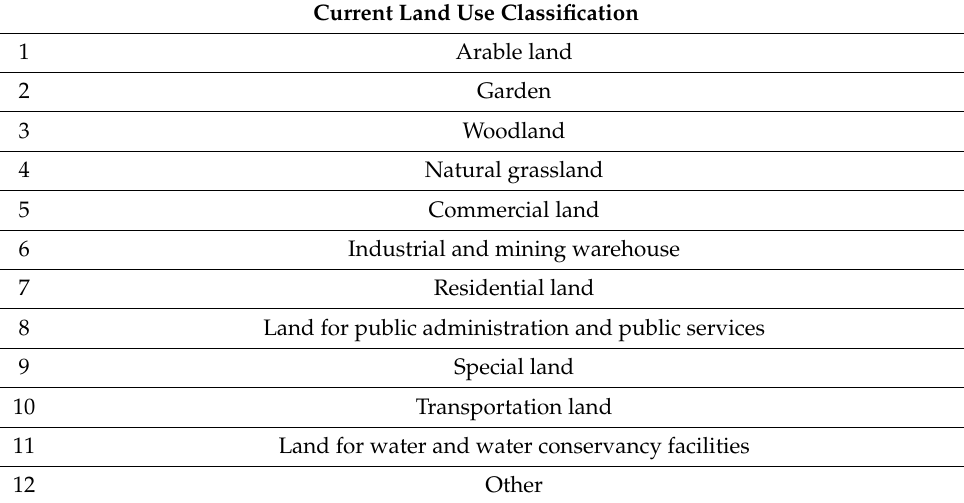
Table 1. Land use classification in China (GB/T21010–2017), published by Ministry of Land and Resources in 2017